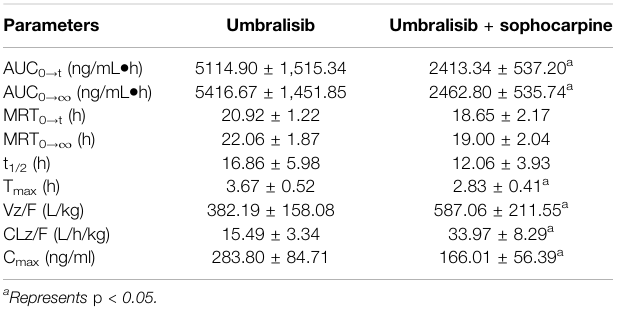
TABLE 5 | The main pharmacokinetic parameters of unbralisib with or without sophocarpine in rats ( n (cid:1) 6, Mean ± SD). Parameters